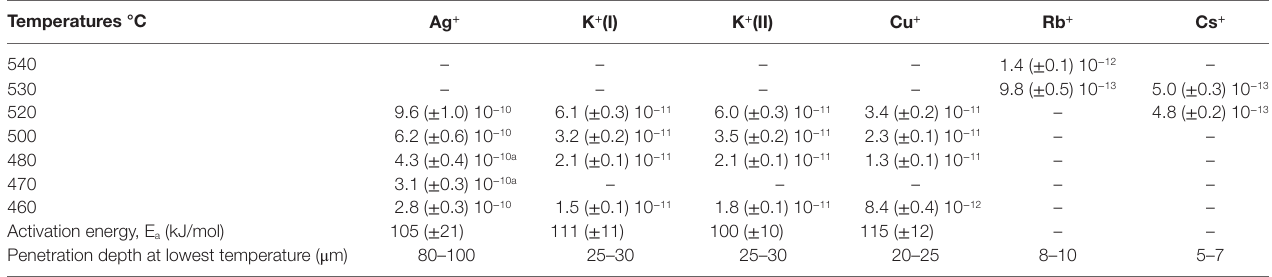
taBLe 3 | overview of effective diffusion coefficients (cm 2 s − 1 ) of several monovalent cations in commercial float glass during 10 h of ion exchange (Karlsson et al., 2010b, 2012, 2013). temperatures